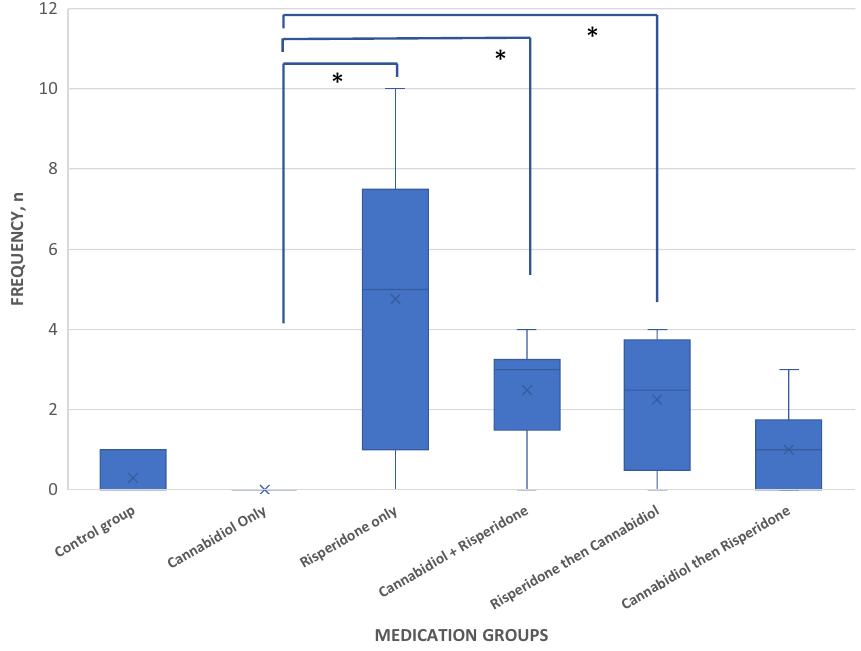
Figure 2. Vacuous chewing movements (VCM) across groups after the last dose of medications. CBD had effects on risperidone induced VCM. *Statistically significant difference.